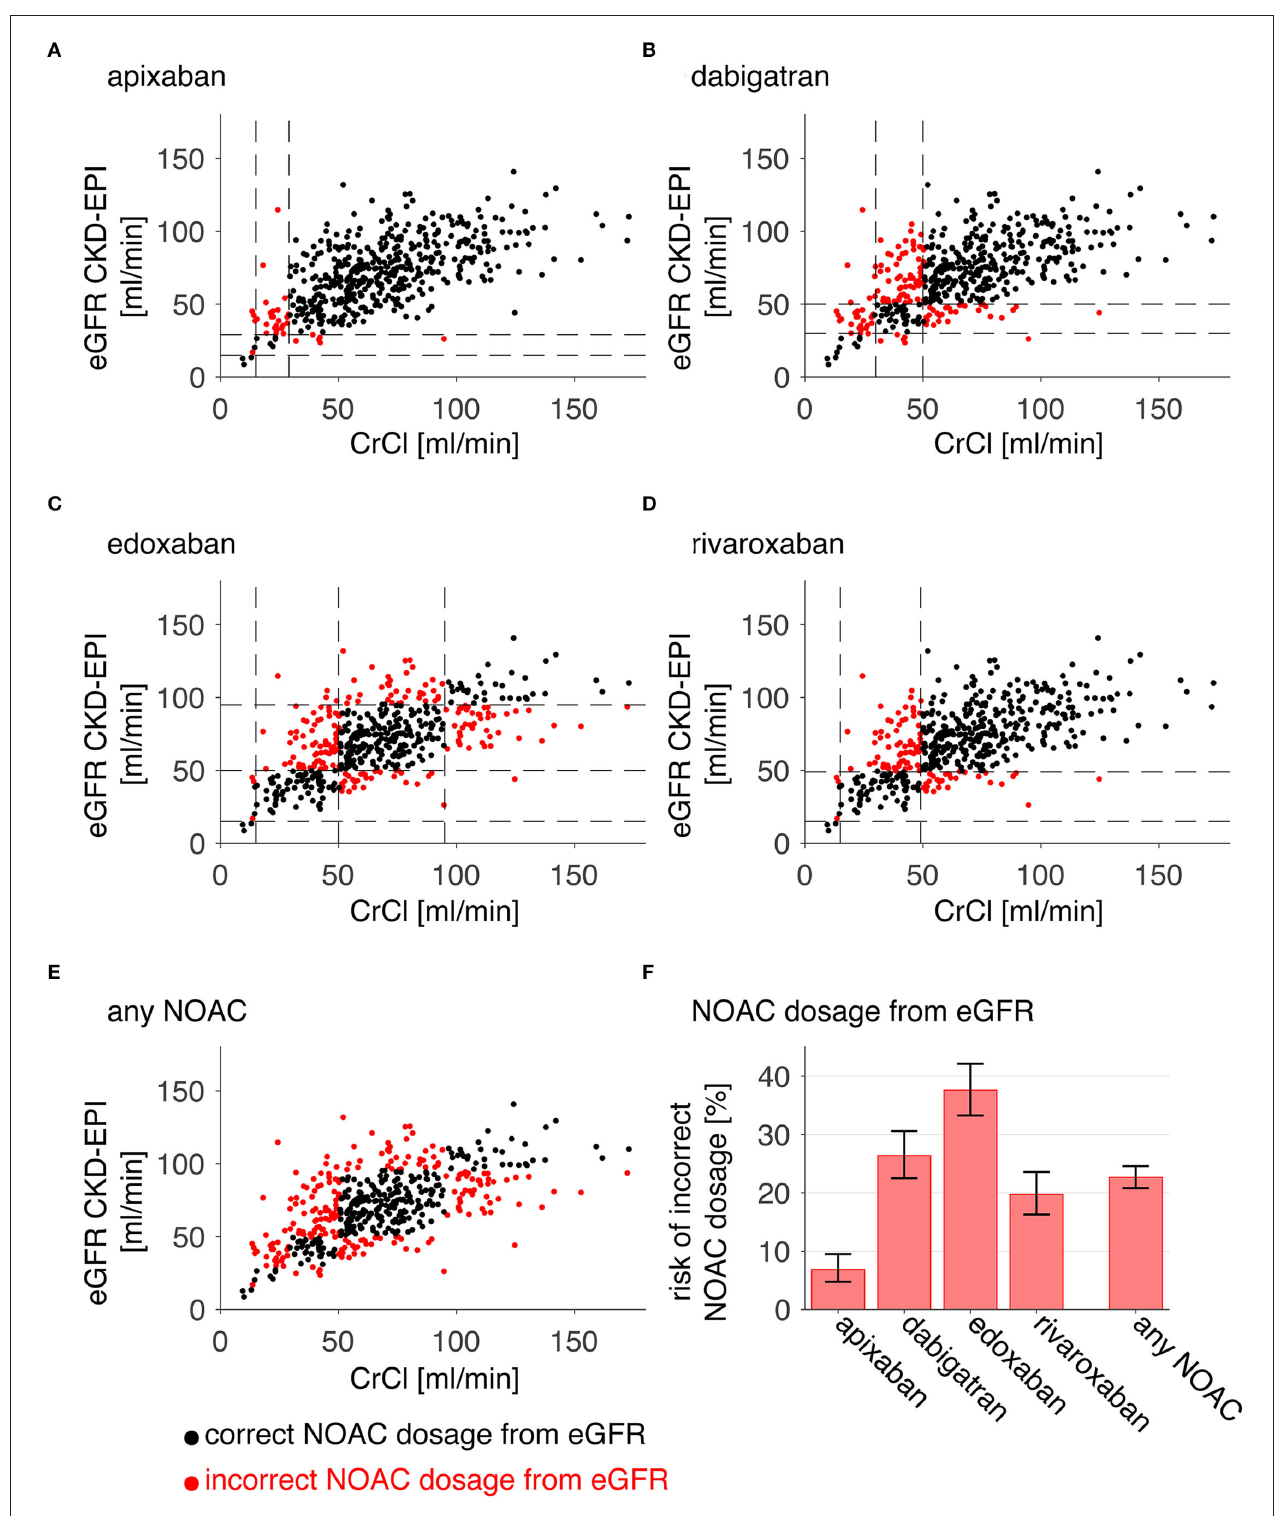
FIGURE 1 | Risk of incorrect NOAC dosage. For each patient, eGFR CKD-EPI is plotted against CrCl (A–E) . Red points denote patients who would have an incorrect dosage or contraindication for apixaban (A) , dabigatran (B) , edoxaban (C) , rivaroxaban (D) , or either of these NOACs (E) when relying on eGFR CKD-EPI instead of CrCl [dashed lines in (A–F) mark the relevant GFR limits for the individual NOAC]. The relative portion of occurrences is plotted for each NOAC and all NOACS (“any NOAC”), and thus indicates the risk of an incorrect dosage (error bars are 95% confidence intervals derived from Clopper-Pearson intervals).